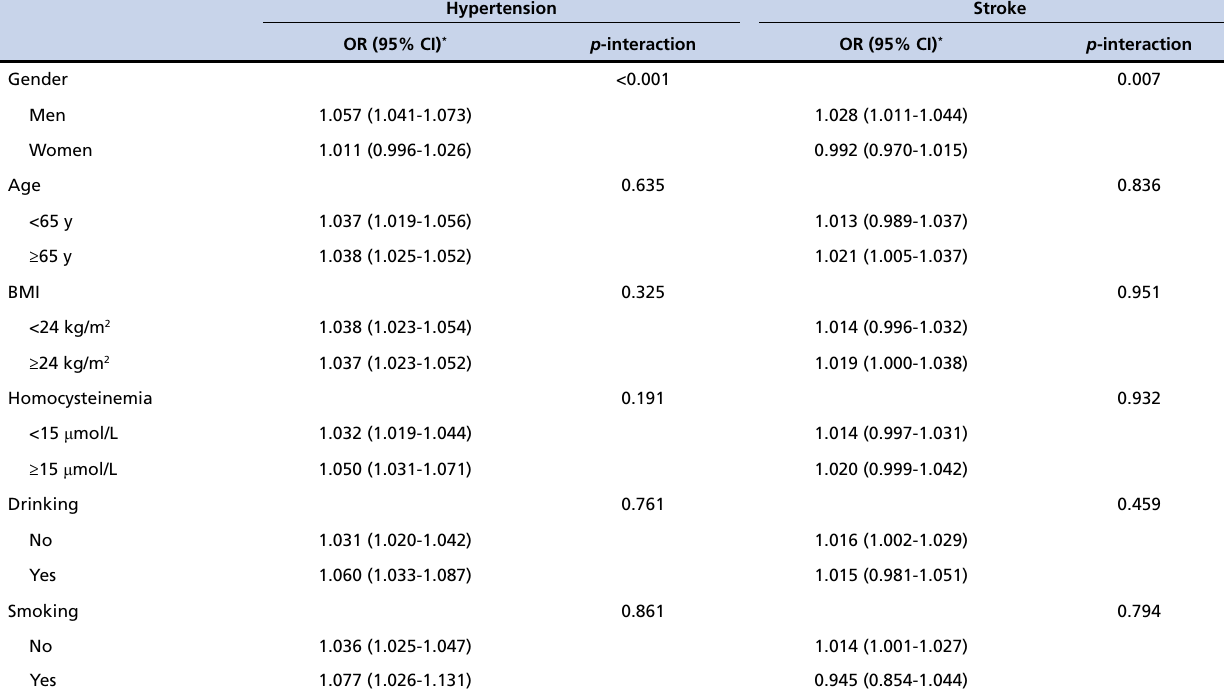
Table 3 - Multivariate-adjusted odds ratios and 95% confidence intervals of hypertension and stroke for CBS methylation in subgroups.